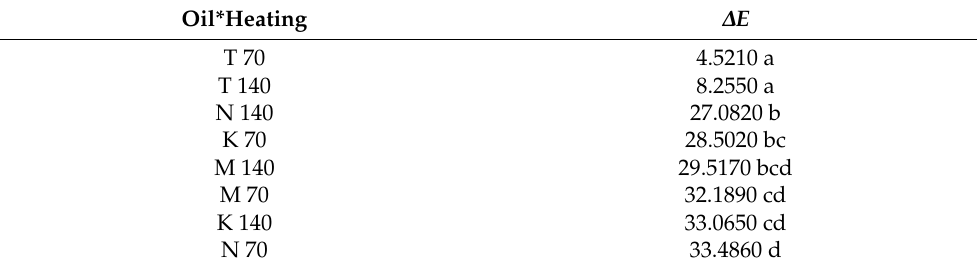
Table 7. The Duncan test for color change (  E ).